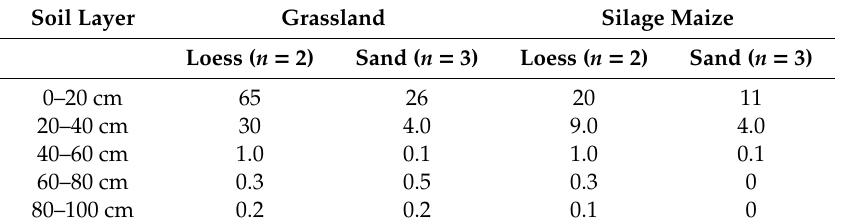
Table 2. Potential denitrification 1 (mg N/kg dry soil/day) in grassland and arable land cropped with silage maize in different soil layers of sandy and loess soils in the Netherlands [47]. The denitrification potential is the denitrification measured under anoxic conditions at 20 °C with an excess of nitrate.